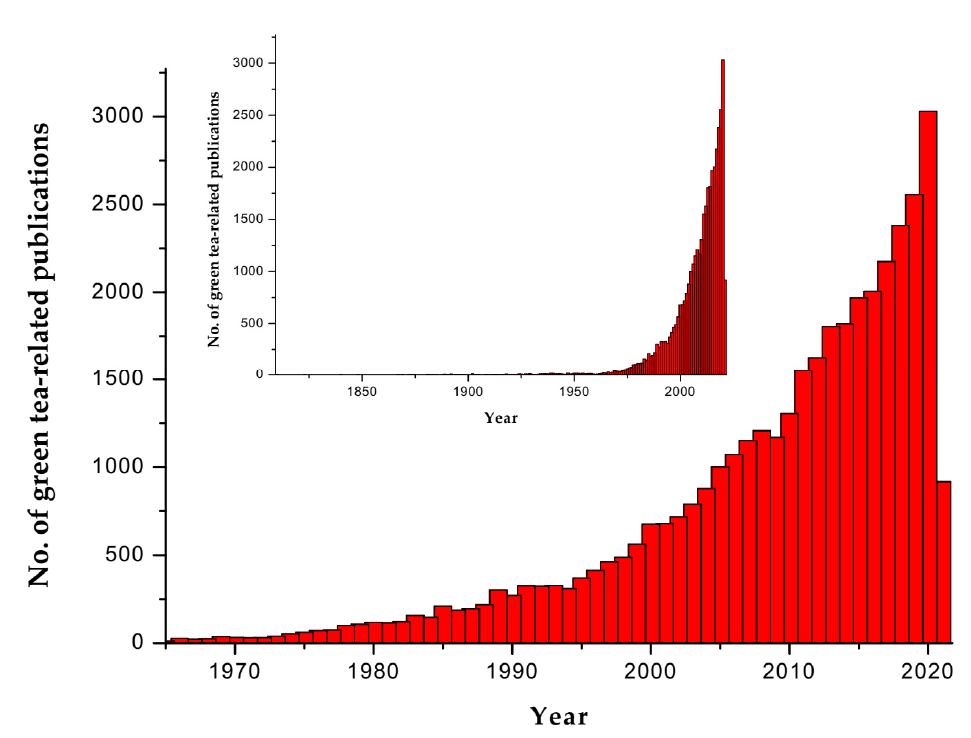
Figure 3. Graph showing research trends in the area of green tea based on a PubMed search; inset showing the trend from 1800s.